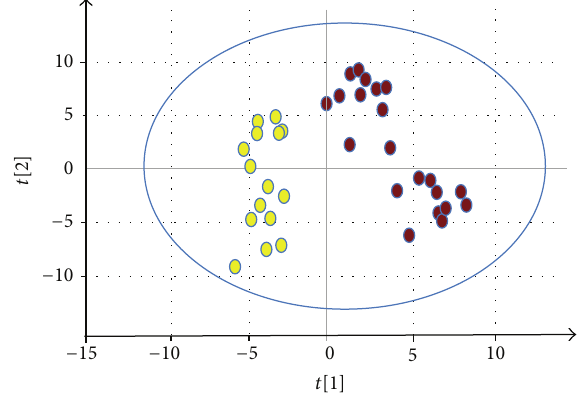
Figure 2: Predictive model (FSGS/normal controls). Partial least squares discriminant analysis (PLS-DA) model for discrimination of healthy controls (yellow circles) and FSGS (red dots) patient samples.